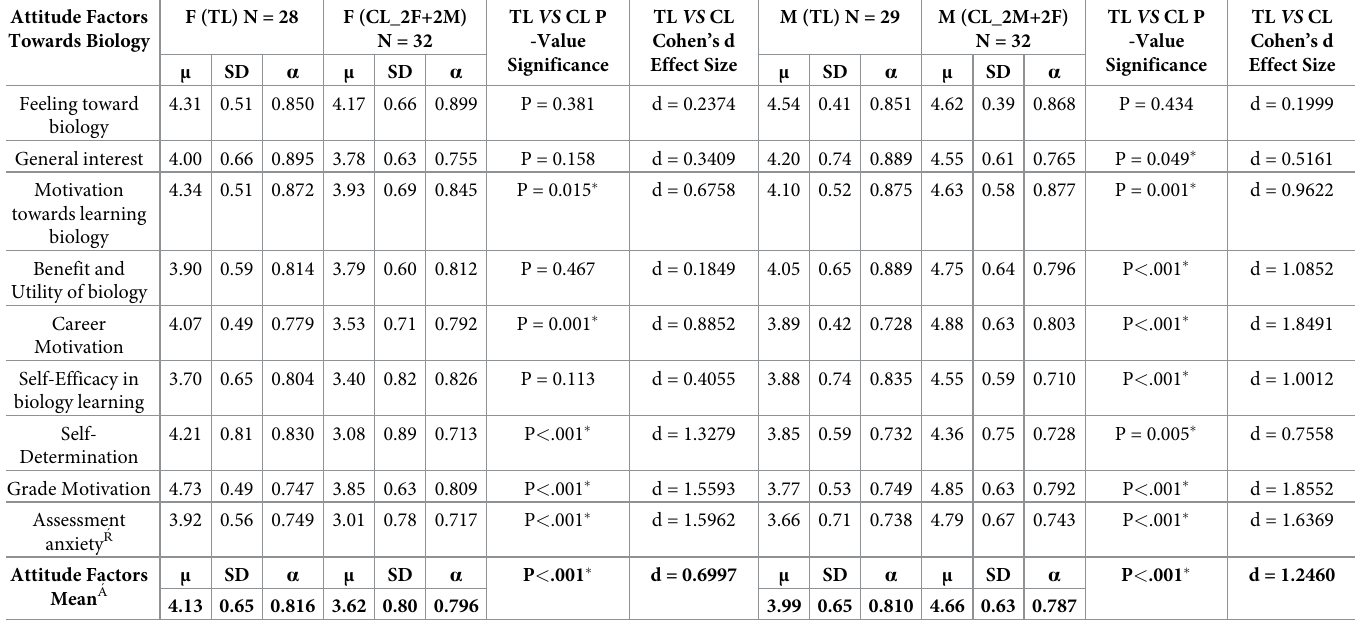
Table 5. Major mix-gender biology students’ attitude means, standard deviations, and reliability of attitude scale components for each attitude